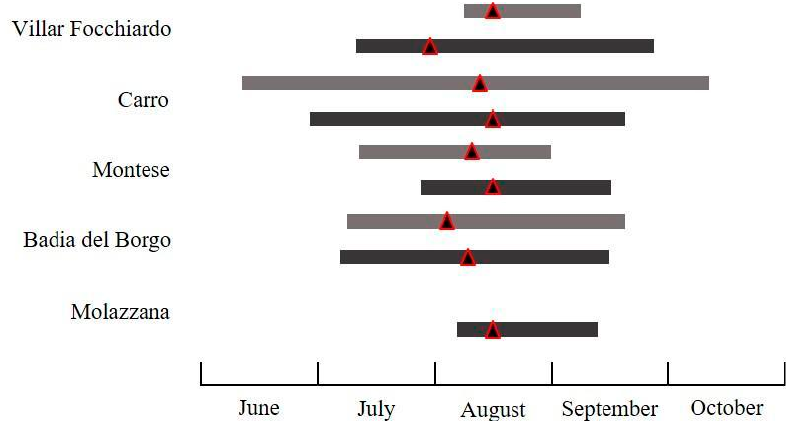
Figure 4. Seasonal flight activity of Cydia fagiglandana (Zeller) recorded in the surveyed sites using the commercially available pheromone (grey bars refer to 2018, black bars to 2019. For each bar, the triangle corresponds to the population peak).